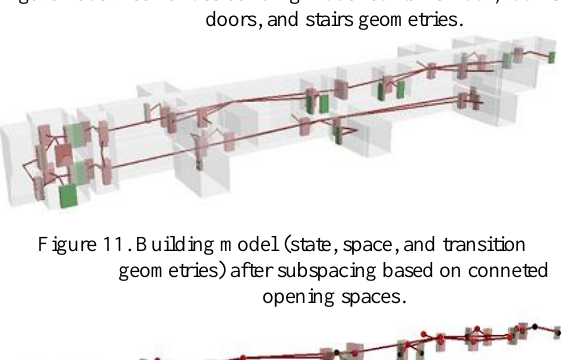
Figure 9 : Work flow of 3D building model in CityGML to IndoorML database and subspacing.